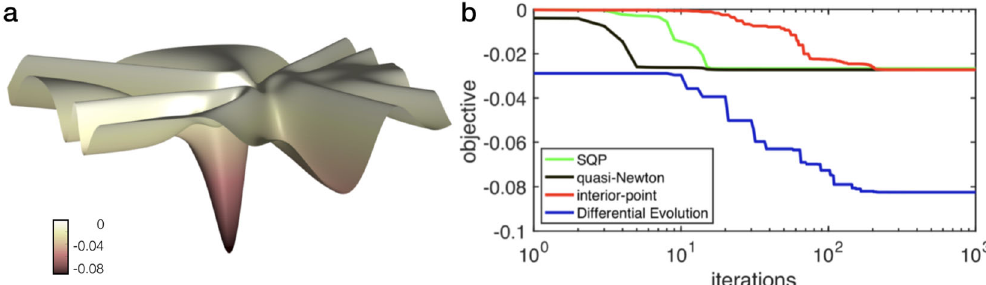
Fig. 9 Visualization of the nonconvex landscape and the failure of the greedy algorithms. a The optimization surface of (minus) the power factor − Q around the global-optimum solution W (cid:4) Q positioned at the center. We here project the high-dimensional optimization landscape onto the two-dimensional surface based on the approach used in ref. 57 . b The convergence behavior of the optimization of the objective function − Q for the sequential quadratic programming (SQP; green), the quasi-Newton method (black), the interior-point algorithm (red), and the differential evolution (blue). The parameters are N f = 4, ϵ l = l Δ with Δ / k T = 3, γ = γ ≡ γ , and we plot the power factor in the unit of k γ / T . Here, N f is the number of single-electron levels, Δ is the energy B h c B spacing, and γ h,c represent the hopping rates to the hot and cold reservoirs.